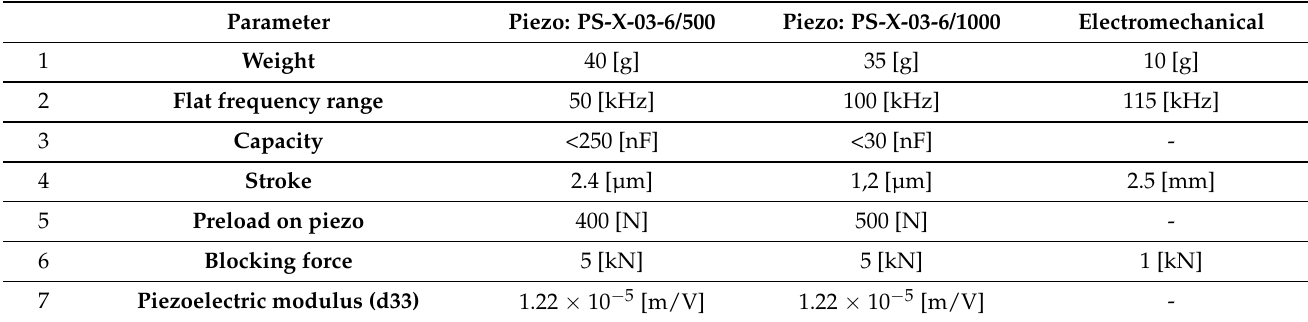
Table 1. Electrical and mechanical parameters of the emitters.